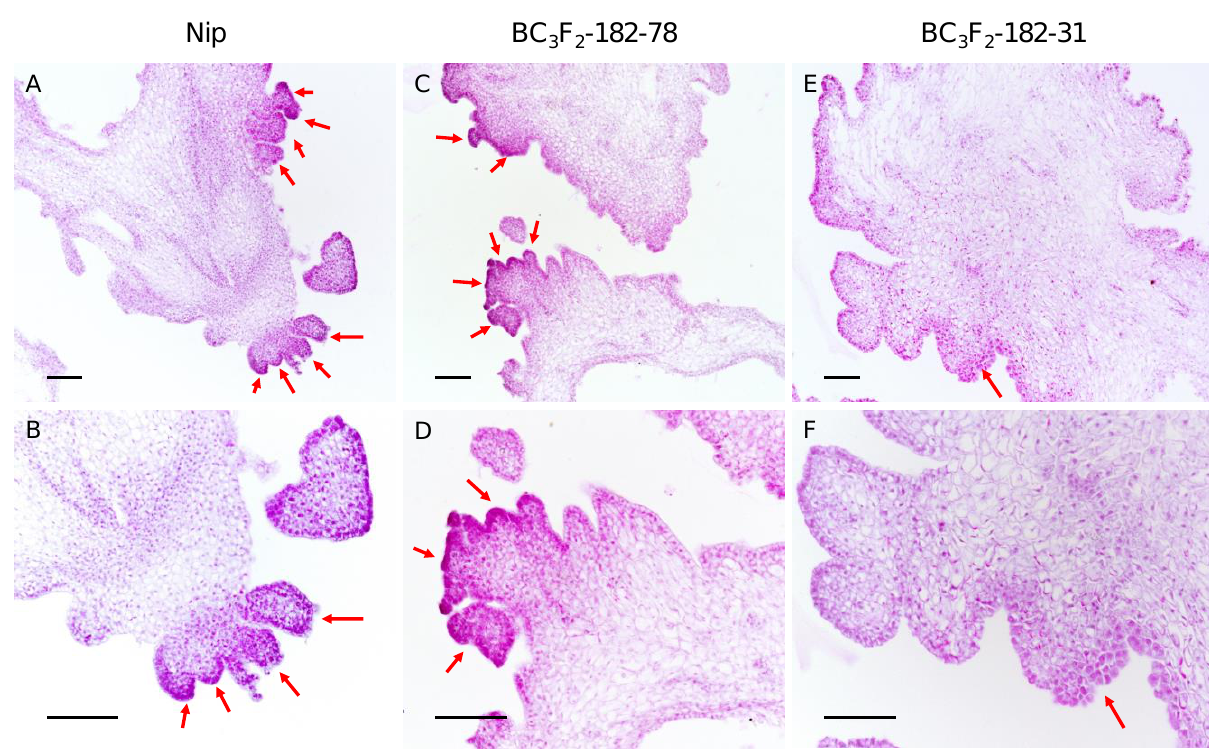
Figure 5. Paraffin section observation of calli after 15 days of regeneration culture. After 15 d of regeneration culture, regenerated shoots appeared. Red arrow: regenerated shoot primordia; top: callus under 10 × objective lens; bottom: callus under the same field of 20 × objective lens. ( A , B ): Nip callus, showing a large number of shoot primordia in the form of clustered shoots. ( C , D ): for the callus of the homozygous-positive family BC 3 F 3 -182–78, a large number of shoot primordia coexisted in the form of single shoots and cluster shoots. ( E , F ): for the callus of the homozygous- negative family BC 3 F 3 -182–31, there were very few shoot primordia in the form of single shoots. Bar values represent 100 µ m. Table 2. Candidate genes of qPRR3